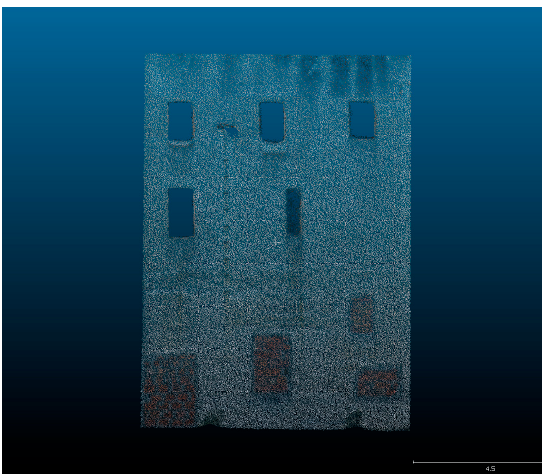
Figure 22. UAV Nadir + Oblique in Photoscan. ISPRS Int. J. Geo-Inf. 2017 , 6 , 393